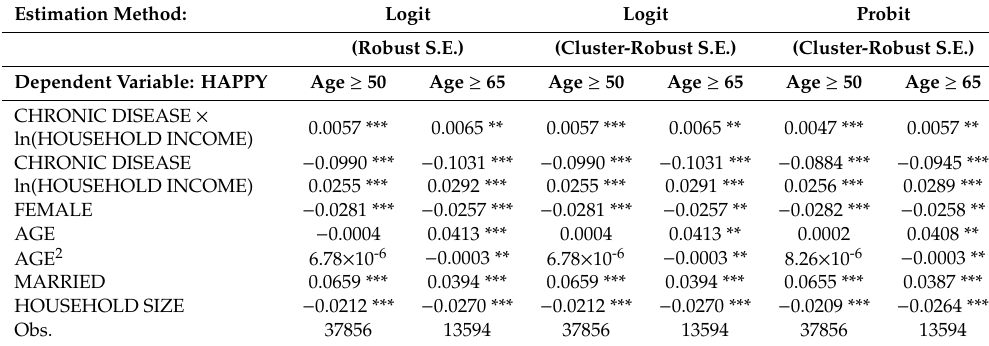
Table 13. E ff ects from discrete choice